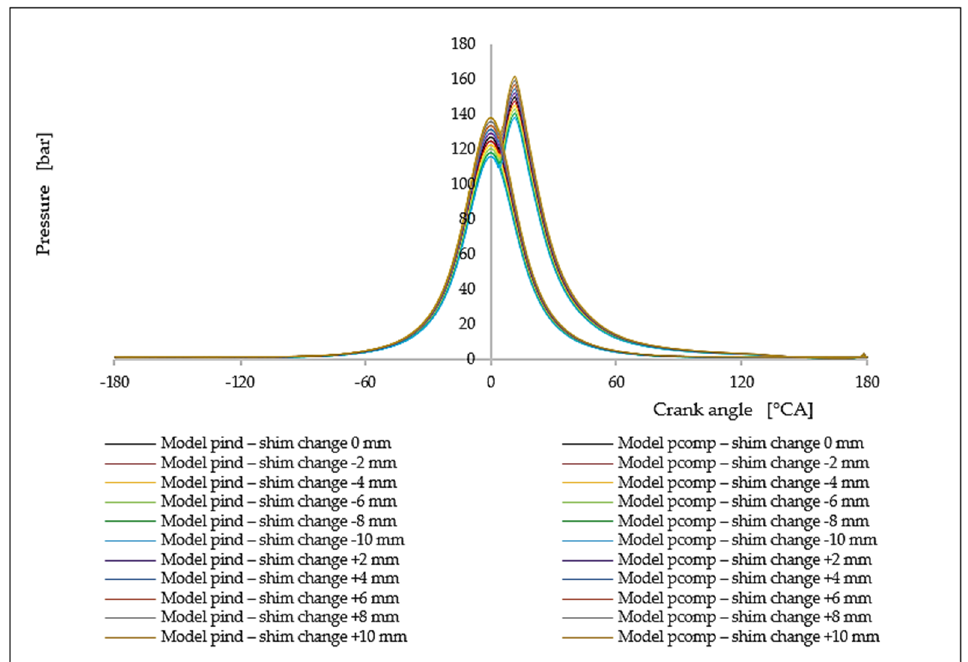
Figure 11. Dependence of combustion and compression pressure on the change in compression ratio at 50% MCR [22].